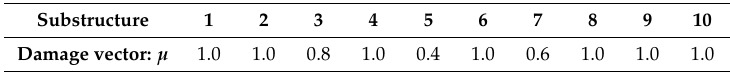
Table 6. Theoretical damage vectors of case 2.